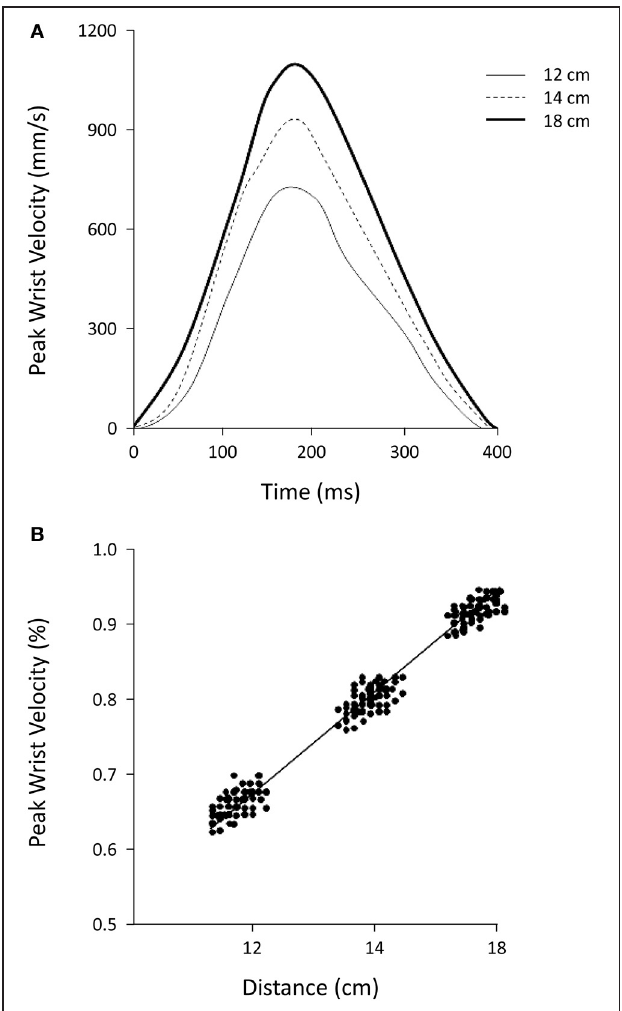
FIGURE 2 | (A) Shows the average peak wrist velocity for objects located at different distances. (B) Shows the relationship between mean peak wrist velocity and distance from the target. Values of peak velocity were normalized to the highest value for each subject. A linear regression very accurately fits the data points. The data outlined in the two panels are from one representative subject ( N = 8).